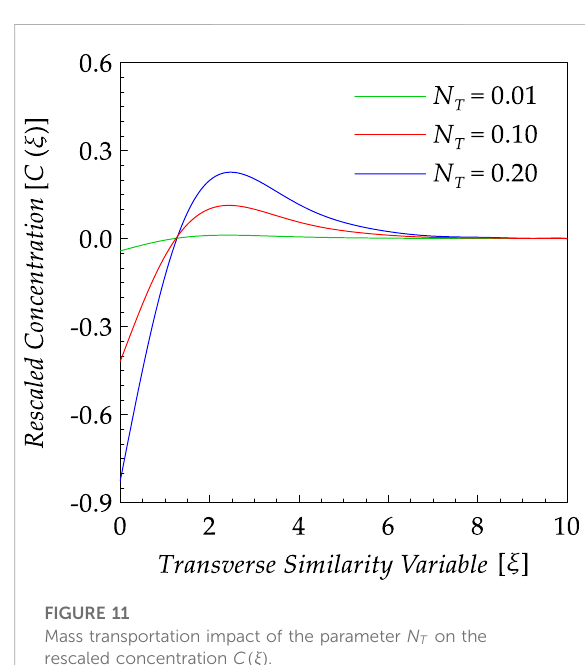
FIGURE 11 Mass transportation impact of the parameter N T on the rescaled concentration C ( ξ ) .